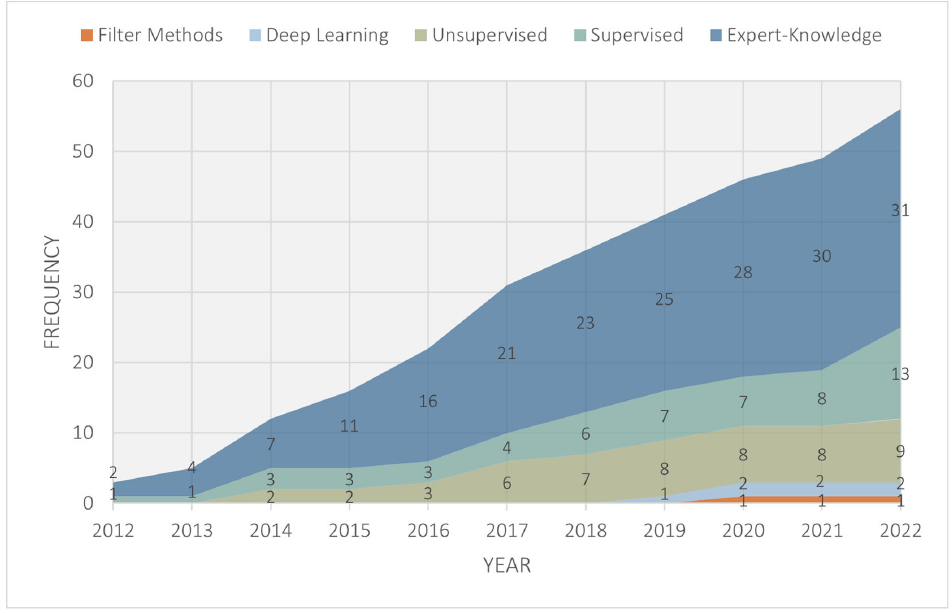
Figure 6. Analysis methods and cumulative trends.